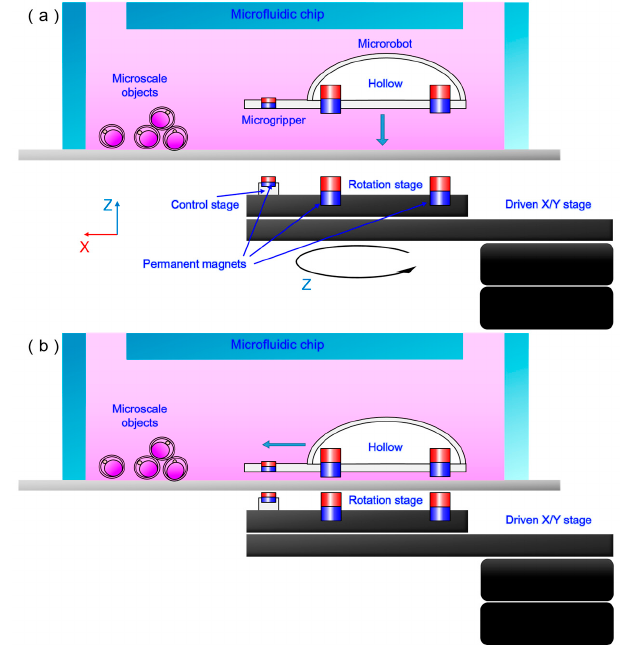
Figure 2. The design of the microrobot. A cavity is placed inside the main body of the robot to provide the buoyancy needed for